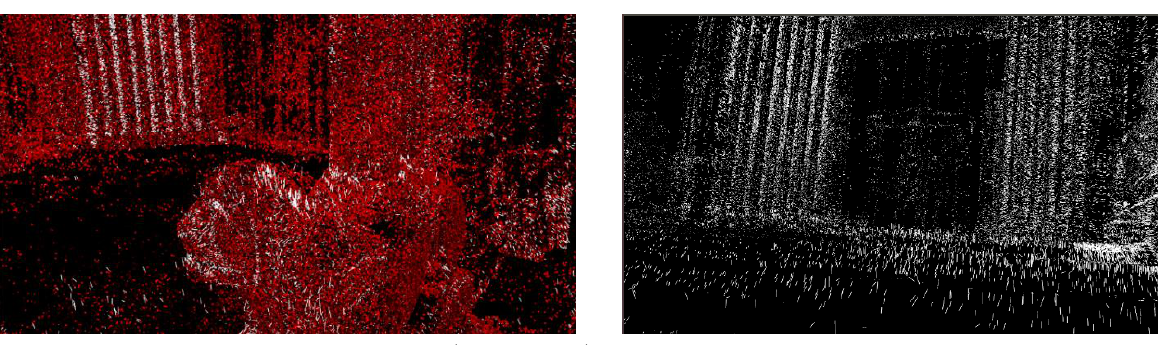
Figure 6: Two different visualizations of the DoN vectors (radii 0.03-0.3 m) computed in the area of the main entrance of the Cathedral: fine-detailed parts (architectural ornaments – left and steps - right) present vectors (white segments) with strong magnitude. On the left, the visualization of the sparse point cloud (red points) and the DoN vectors (white segments). On the right, only the DoN vectors are showed.